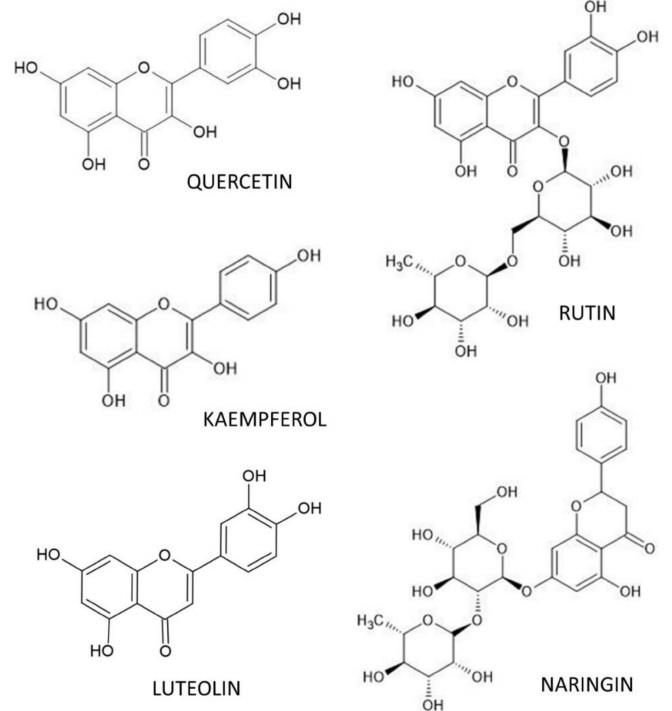
Figure 2. Chemical structures of described flavonoid polyphenols.